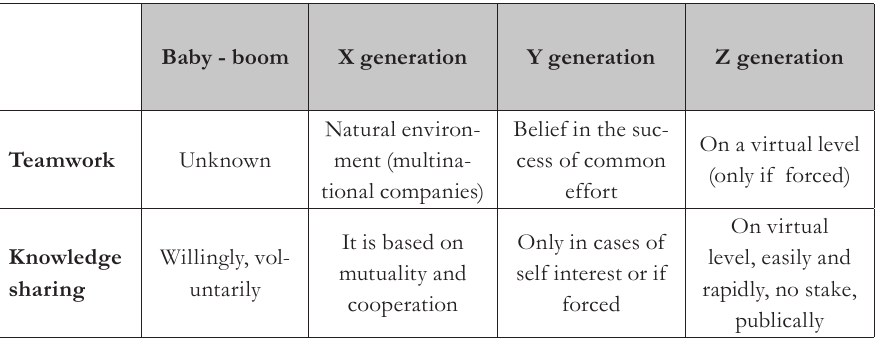
Tab. 1 - Different generational characteristics from a viewpoint of teamwork and knowledge sharing Source: Tóth-Bordásné & Bencsik,